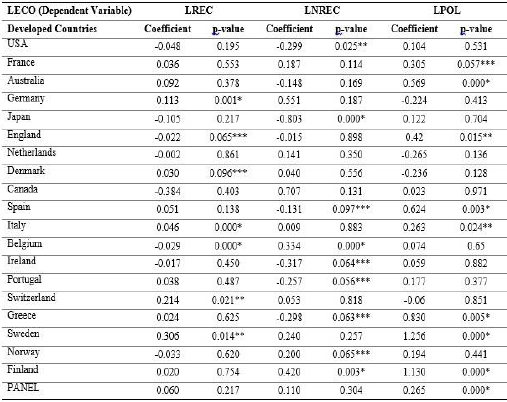
Table 8: AMG Cointegration Estimator Test